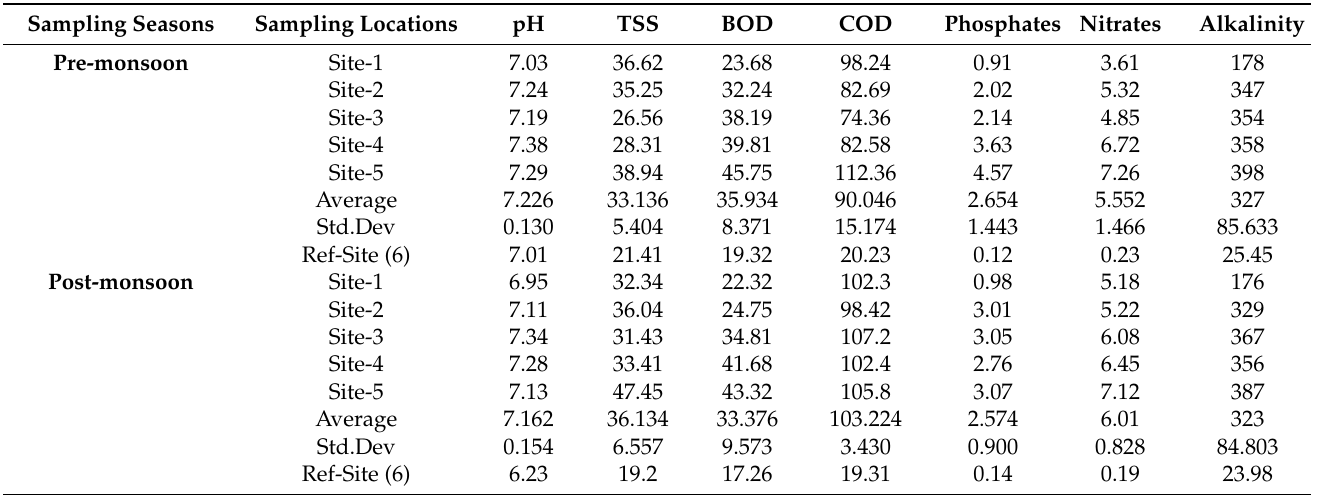
Table 3. Values of physicochemical parameters (mg/L, excluding pH) of water samples taken from the Yamuna River in five different areas during the pre- and post-monsoon